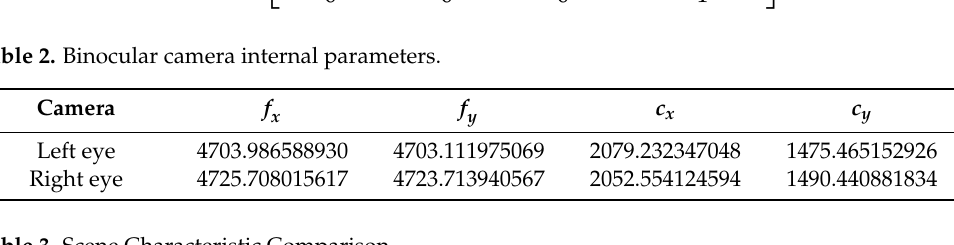
Table 3. Scene Characteristic